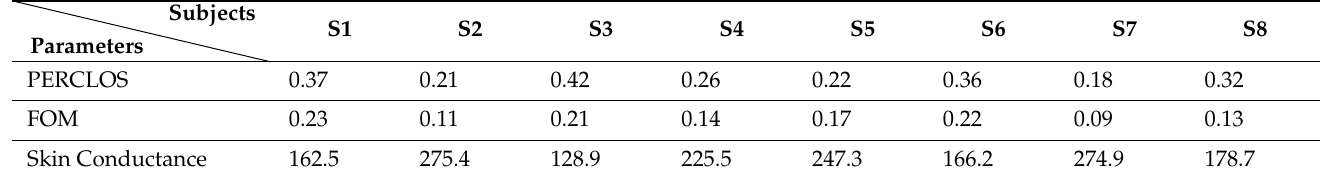
Table 4. Mean value of PERCLOS, FOM and skin conductance for eight subjects.